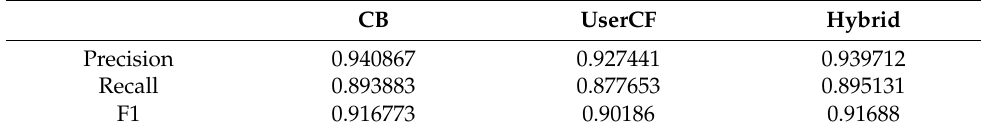
Table 3. Comparison of accuracy of different recommendation approaches.